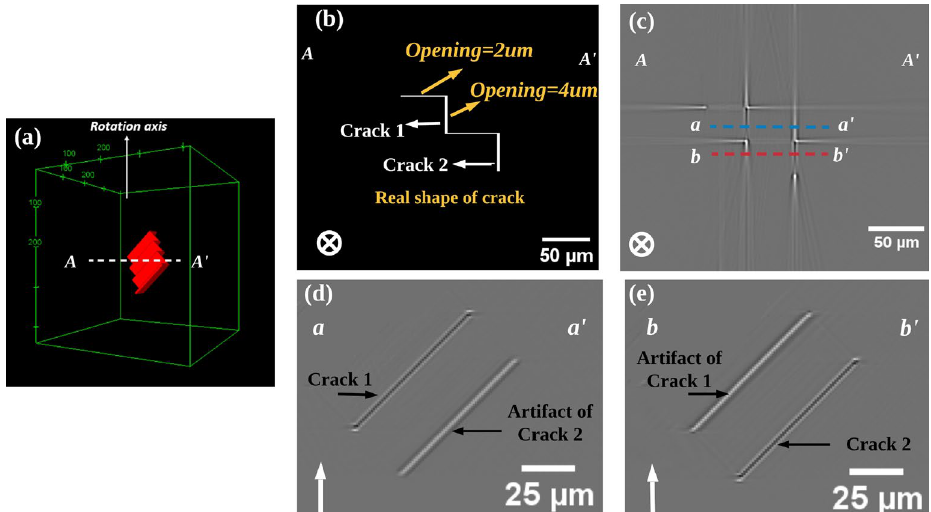
Figure 6. Simulation result (scan conditions as in Fig. 2) of a step-like crack (large steps): ( a ) Phantom’s 3D rendering; 2D section showing the crack in the phantom ( b ) and in the simulated image ( c ) on the plane perpendicular to rotation axis going through A–A ′ line. ( c ) Horizontal slice (A–A ′ ) of the step-like crack, the blue dashed line (a–a ′ ) and the red dashed line (b–b ′ ) mark the positions of the vertical slices shown in ( d ) and ( e ) respectively; ( d , e ) Vertical slices of the step-like crack along the dashed blue line and dashed red line shown in ( b ), ↑ and (cid:31) indicate the rotation axis.